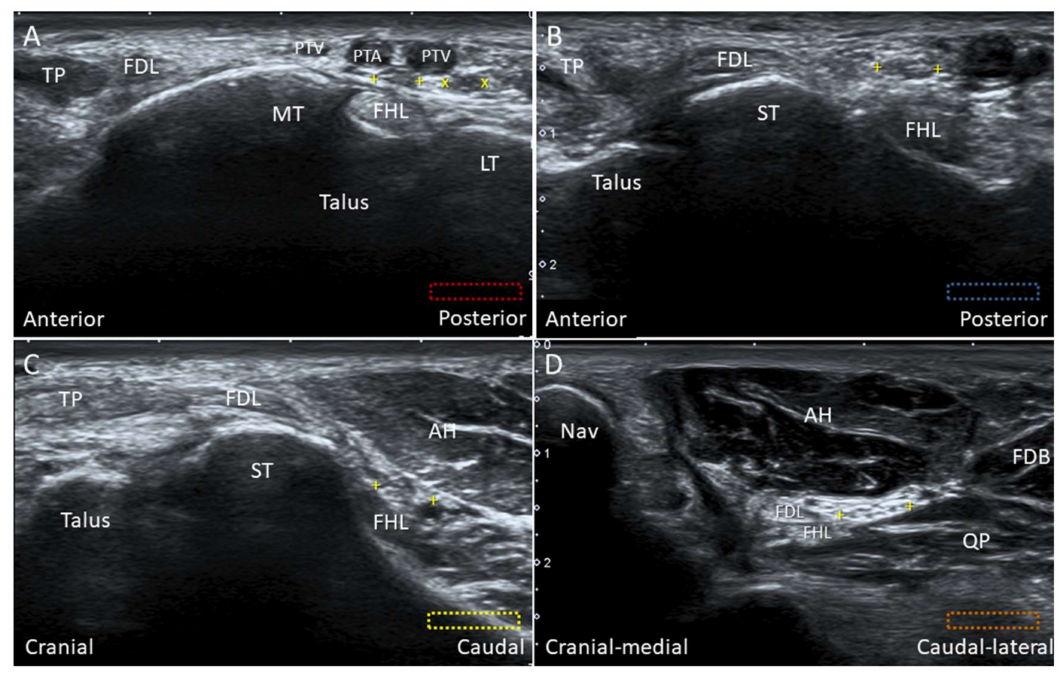
Figure 25. Imaging of the flexor hallucis longus tendon (FHL) at the tarsal tunnel ( A ), at the level posterior to the sustentaculum tali (ST) ( B ), at the level inferior to the ST ( C ) , and at the knot of Henry ( D ). The colored dashed rectangles are in accordance with the transducer positions in Figure 3A. “ + + ”: medial plantar nerve; “x x”: lateral plantar nerve; AH: abductor hallucis muscle; FDB: flexor digitorum brevis muscle; FDL: flexor digitorum longus tendon; LT: lateral tubercle of the posterior talar process; MT: medial tubercle of the posterior talar process; Nav: navicular; PTA: posterior tibial artery; PTV: posterior tibial vein; QP: quadratus plantae muscle; TP: tibialis posterior